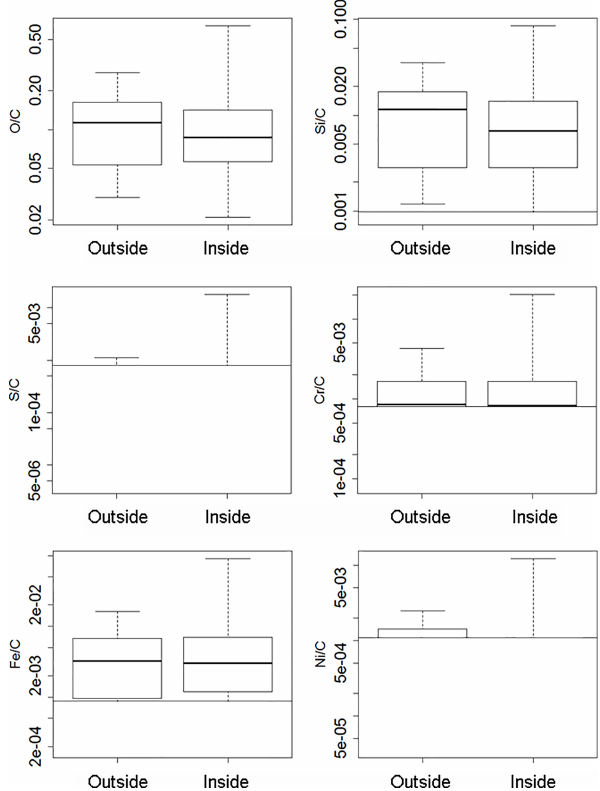
Figure 8. Censored box plots of element ratios (atom%) relative to C, separately for outside and inside the polar vortex. Sample K was excluded from the analysis due to the different substrate used. Lower and upper quartiles appear as a box, and minimum and max- imum values as whiskers. Values below detection limit (horizontal line) are not